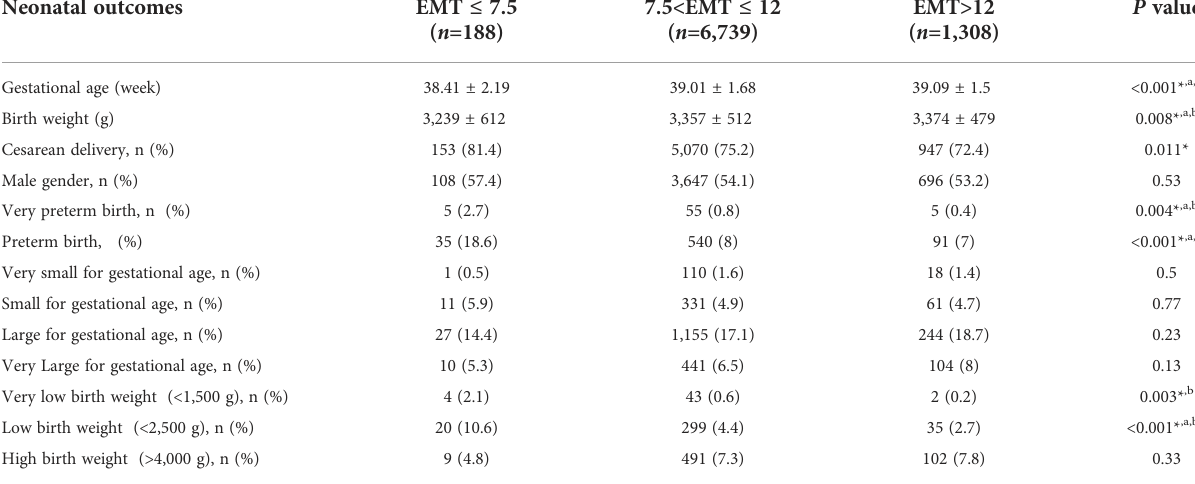
TABLE 2 Neonatal outcomes for singleton live births based on endometrial thickness. Neonatal